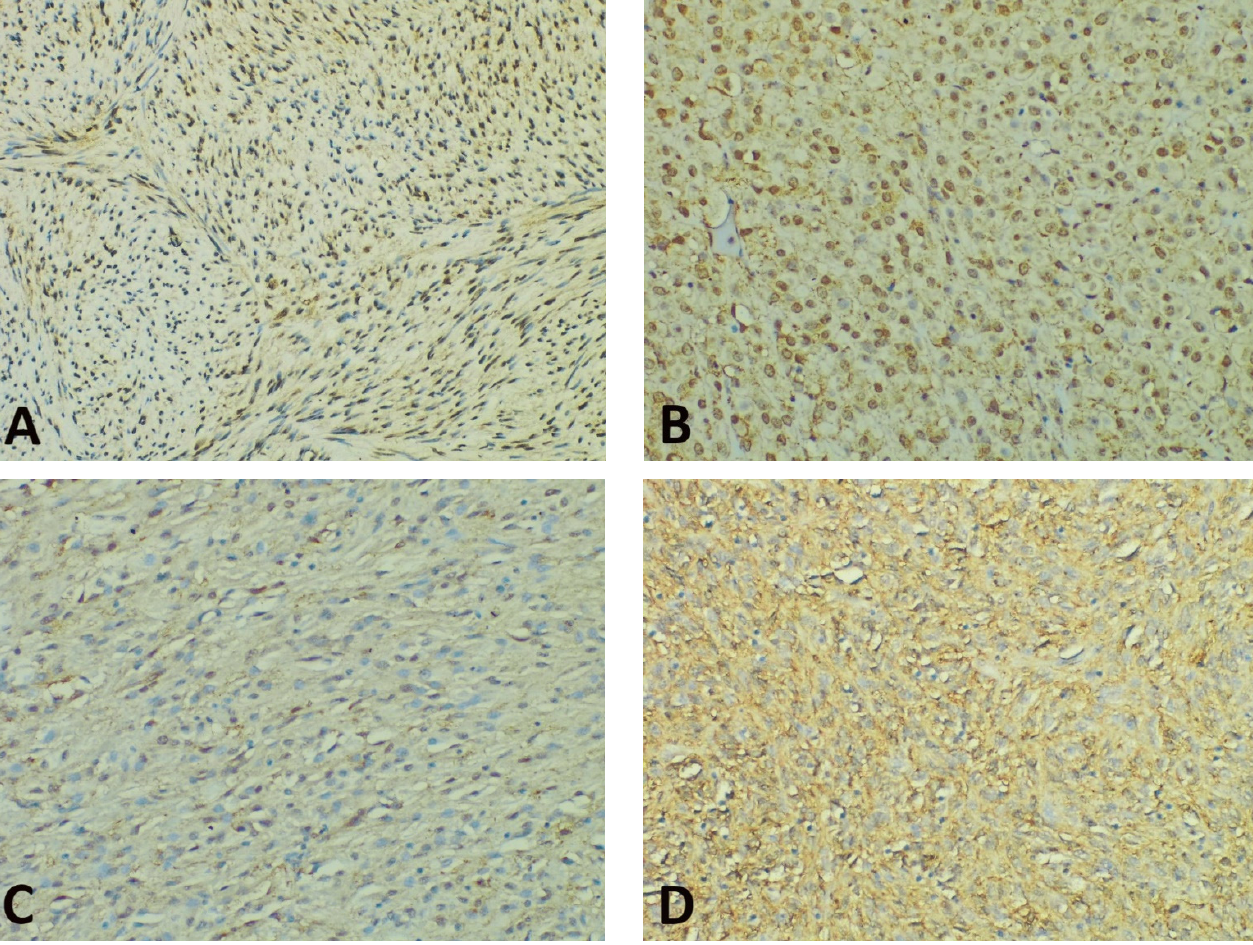
Figure 3. Representative photomicrographs showing GHS-R IHC staining in GISTs, with examples of the evaluation method previously described. Cytoplasmic immunoreactivity was observed in most cases, while a preferential staining pattern was noted in tumor periphery vs. core (IHC, anti-GHS-R antibody, × 200 magnification). ( A ) Nuclear immunoreactivity in spindle GIST, score 3 (intense); ( B ) Nuclear immunoreactivity in epithelioid GIST, score 2 (moderate); ( C ) Nuclear immunoreactivity in spindle GIST, score 1 (weak); ( D ) Absent nuclear immunoreactivity in spindle GIST (score 0).